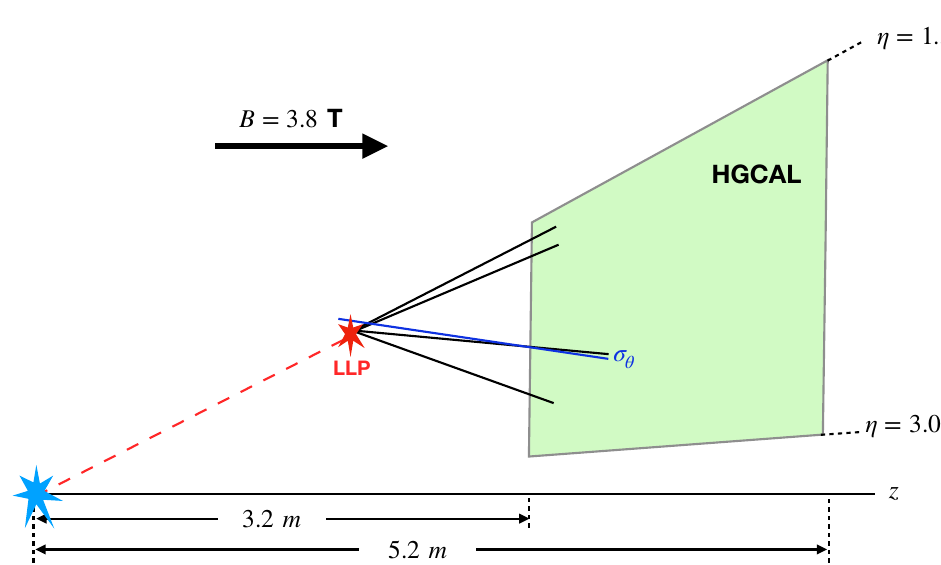
Figure 3 . A schematic drawing for the decay products of the long-lived particle arriving the HGCAL. The direction of the momentum of the decay products can be measured by the HGCAL with an angular resolution of σ θ , resulting in an error in reconstructing the displaced